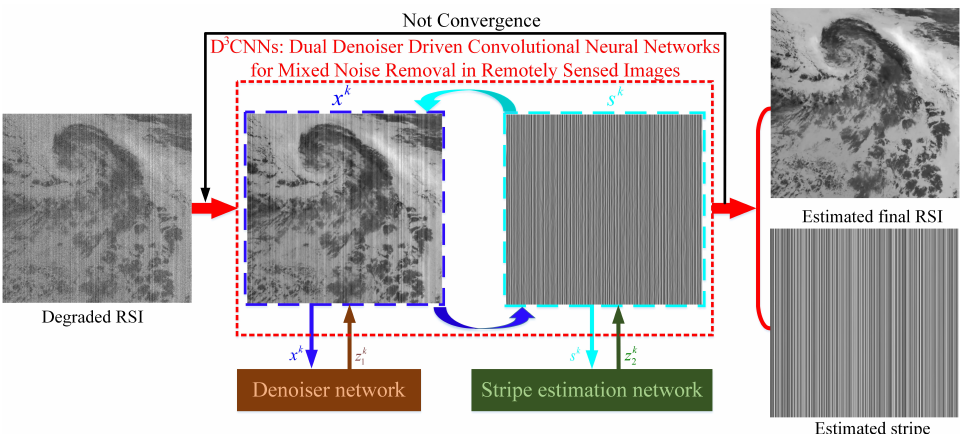
Figure 2. Flowchart of the proposed D 3 CNNs